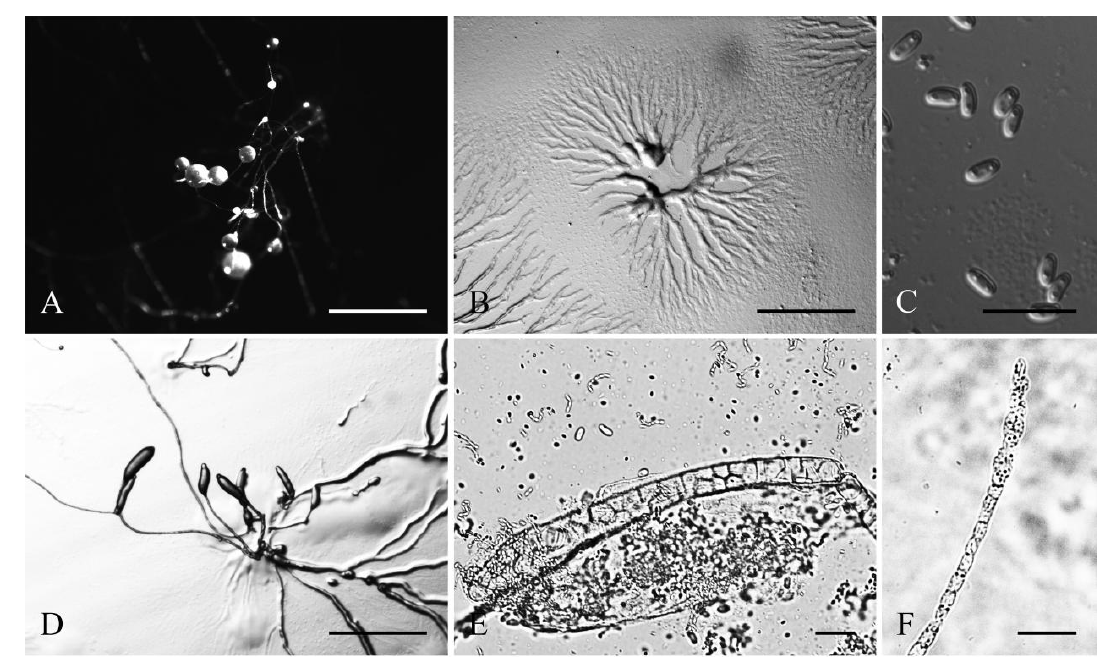
Figure 1. Morphological features of Cavenderia helicoidea (TH19B). ( A ), Sorocarps. ( B ), Aggregations. ( C ), Spores. ( D ), Clustered pseudoplasmodia. ( E ), Sorophore base. ( F ), Sorophore tip. Bars: ( A , B ) = 1 mm; ( C ) = 20 µ m; ( D ) = 1 mm; ( E , F ) = 20 µ m.